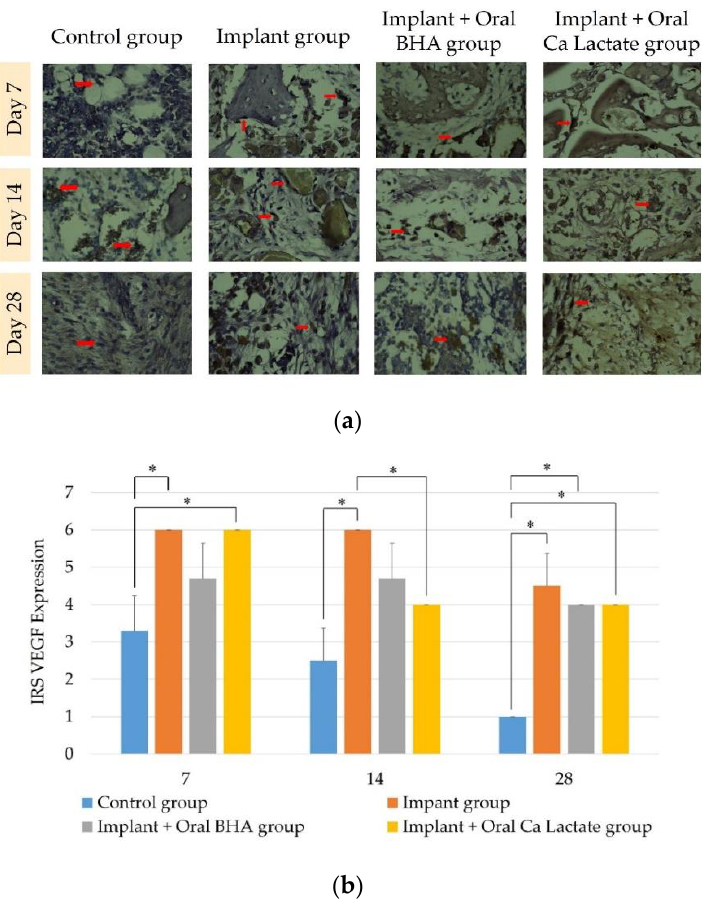
Figure 4. ( a ) Immunohistochemistry of VEGF expression (400× magnification). VEGF-positive cells are indicated by brown osteoblasts (red arrows); ( b ) differences in IRS values of VEGF expression, each bar graph represents IRS ± SD. The sign (*) indicates p < 0.05 with the Mann – Whitney Test.